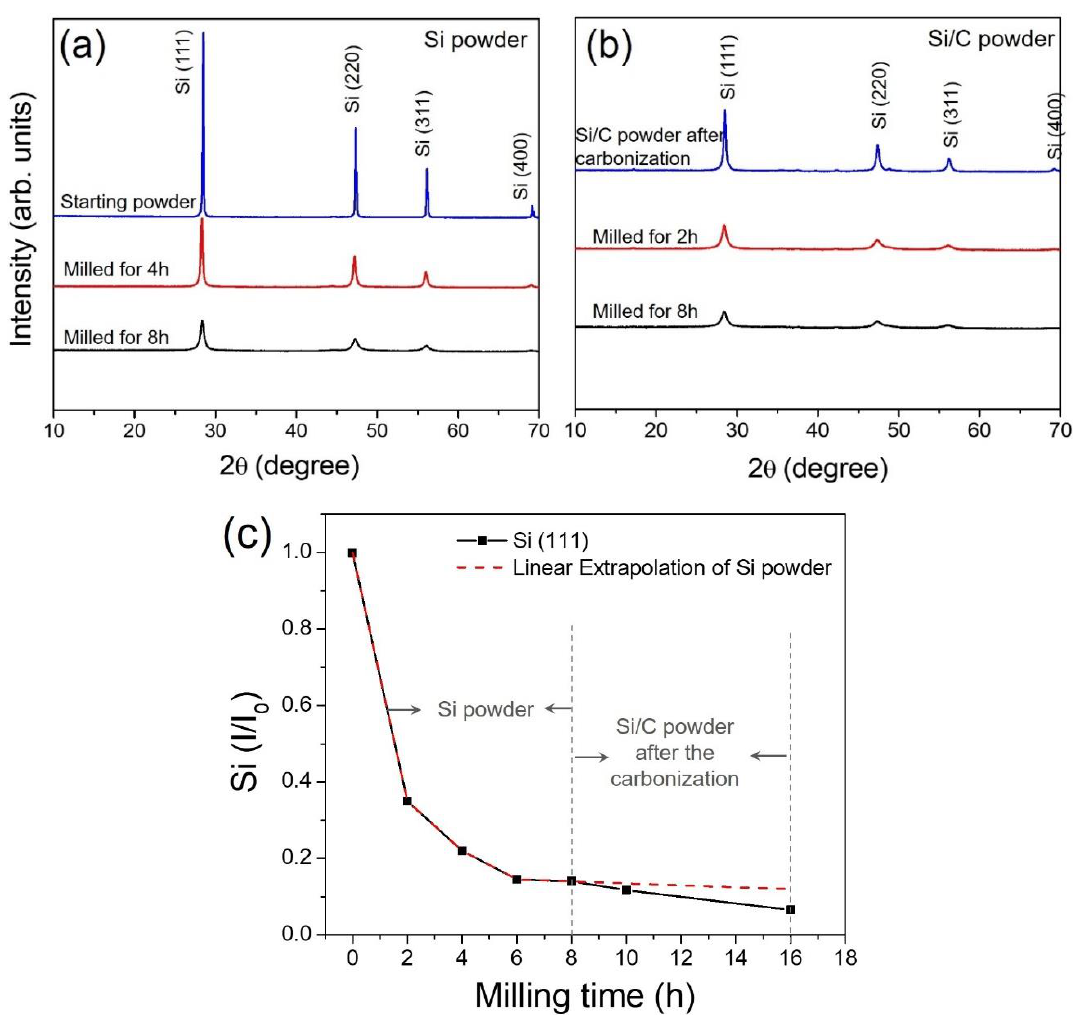
Figure 1 . X-ray diffraction patterns of the Si and Si/C composite powders: ( a ) Si powder; ( b ) Si/C nanocomposite powder; and ( c ) change in intensity ratio of the Si peak before and after the carbonization with respect to milling time.